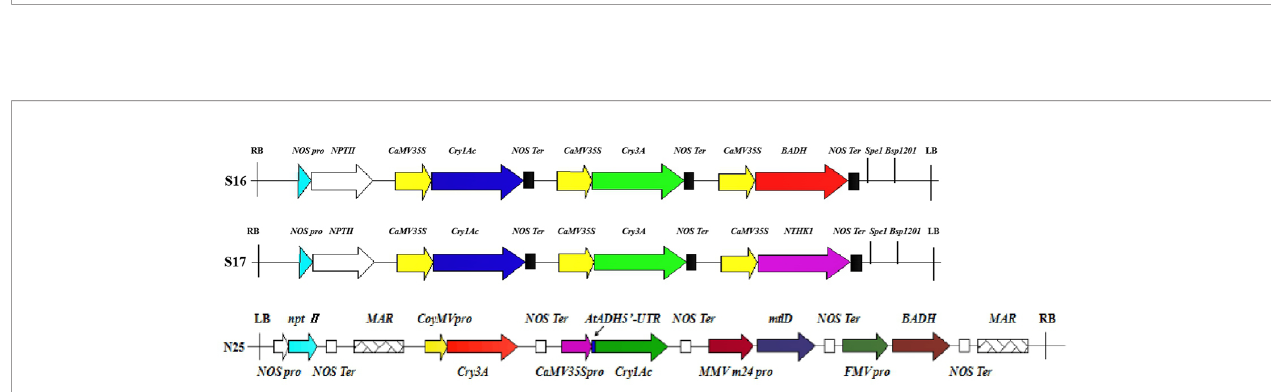
FIGURE 10 | Comparison of multigene carrier structures. S16, S17, and N25 represent the carrier structures of Yang et al. (2016) and Liu et al. (2016), and this experiment. Different colors and shapes represent different components. RB, right boundary of vector. NOS pro, promoter of neomycin phosphotransferase gene; nptII , neomycin phosphotransferase gene; CaMV35S, cauli fl ower mosaic virus CaMV35S promoter; Cry1Ac , bacillus thuringiensis insecticidal crystal protein gene; NOS Ter, terminator of neomycin phosphotransferase gene; Cry3A , bacillus thuringiensis insecticidal crystal protein gene; BADH , betaine aldehyde dehydrogenase gene; Spe1 and Bsp1201, restriction enzyme cutting site; LB, vector left boundary; NTHK1 , an ethylene receptor gene cloned from tobacco; MAR, the molecular structure of the matrix attachment region of tobacco; CoyMV pro, commelina yellow mottle virus promoter; AtADH5 ’ -UTR, translation enhancer; MMV m24 pro, mirabilis mosaic virus promoter; mtlD , 1-phosphomannitol dehydrogenase gene; FMV pro, fi gwort mosaic virus